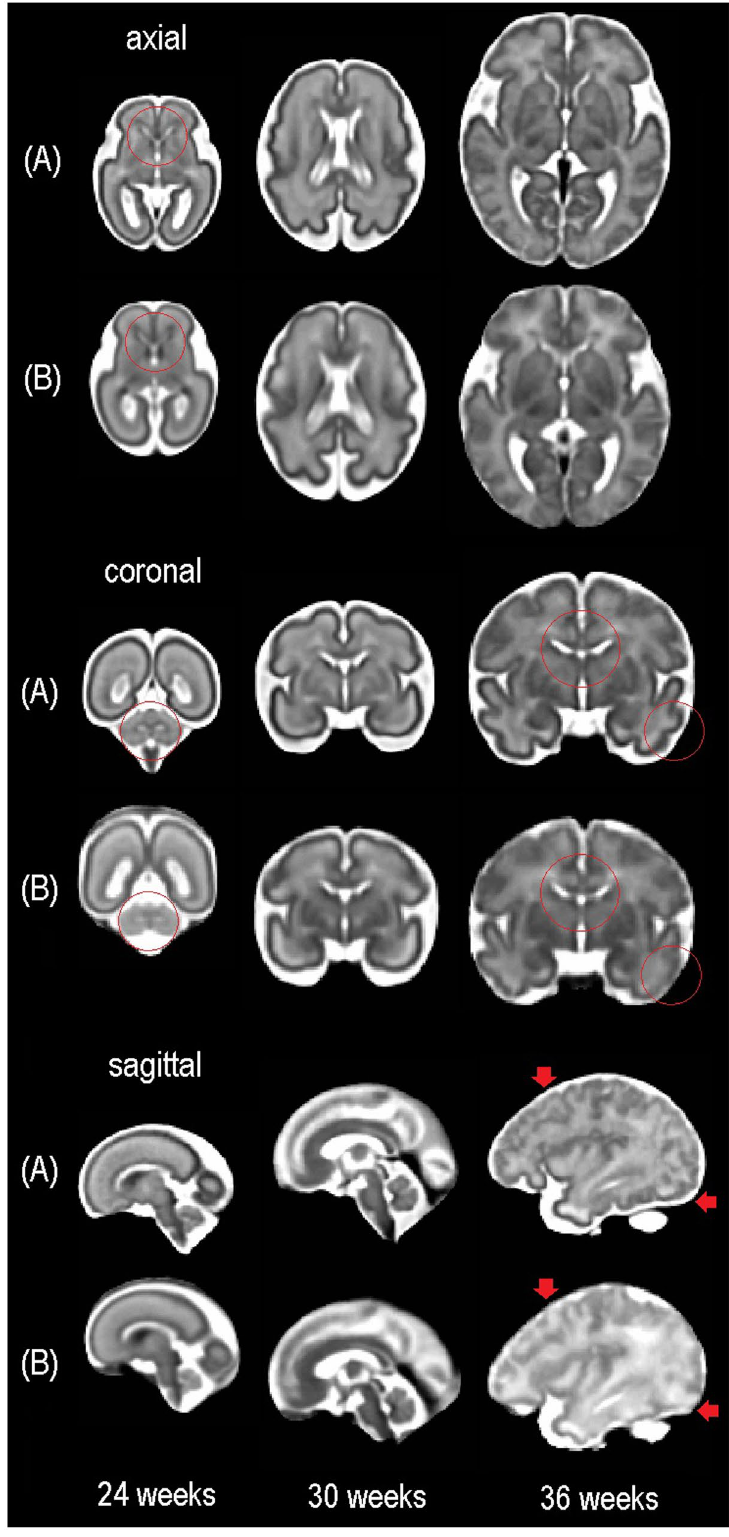
Figure 5. Visual comparison of our spatiotemporal fetal brain MRI atlas ( A ) and the atlas from brain- development.org ( B ). We did not register or resample the atlases to avoid artificial blur; we instead tried to compare the closest planes in each view at three ages (24 weeks, 30 weeks, and 36 weeks GA). The images in ( B ) are generally smoother than those in ( A ) but lack anatomic details compared to the images in ( A ). Red circles and markers point at some of the areas with relatively blurred anatomy on the atlas from brain-development.org but with more details on the CRL fetal brain atlas. Both atlases are available